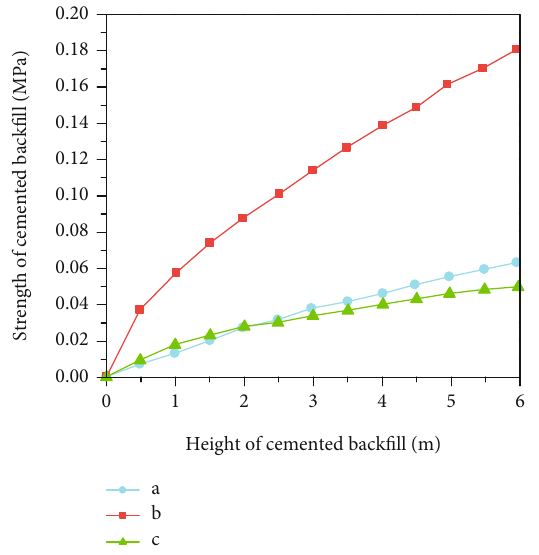
Figure 2: Comparison of self-supporting strength of cement. (a) Empirical equation. (b) Lu Ping modi fi ed model. (c) Thomas